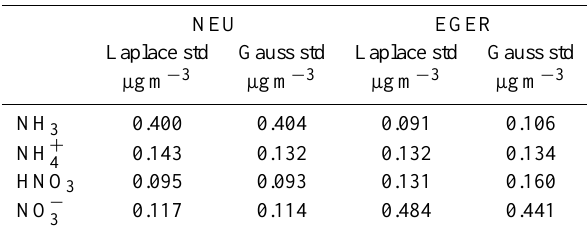
Fig. 6. Diel variation of friction velocity ( u ∗ ) during (a) NEU and (c) EGER and of the stability ( z/L ) during (b) NEU and (d) EGER. Red lines denote the median, the boxes the inter-quartile ranges (0.25–0.75). Table 3. Laplace and Gaussian standard deviations, std 1C of the residuals of the concentration difference obtained during the side- by-side measurements after correcting the data for systematic devi- ations using the orthogonal fit for NEU and